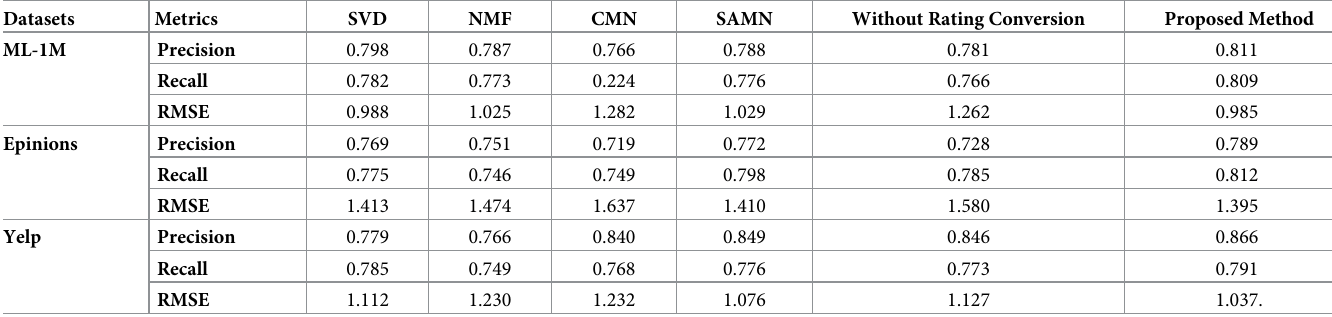
Table 7. Predicted accuracy experimental